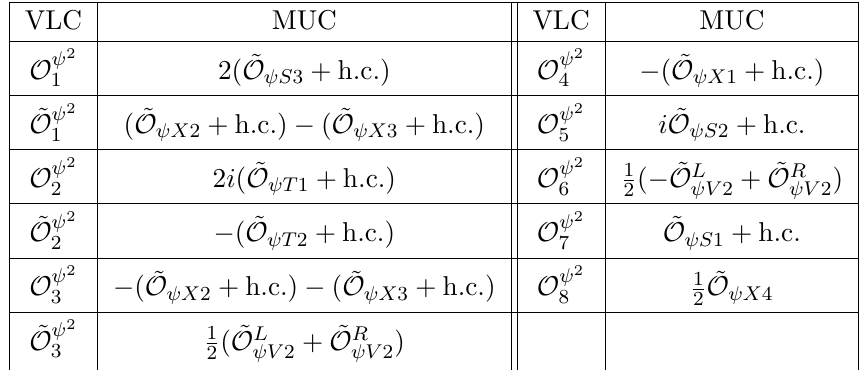
Table 8 . Dictionary of fermionic bilinear